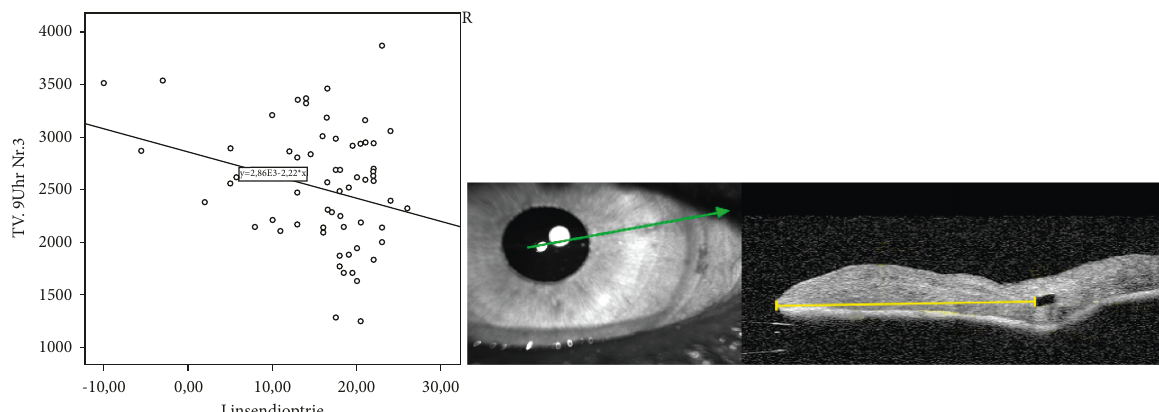
Figure 6: Relationship between IOL diopter and the distance between the inner haptic boundary and the pupillary zone